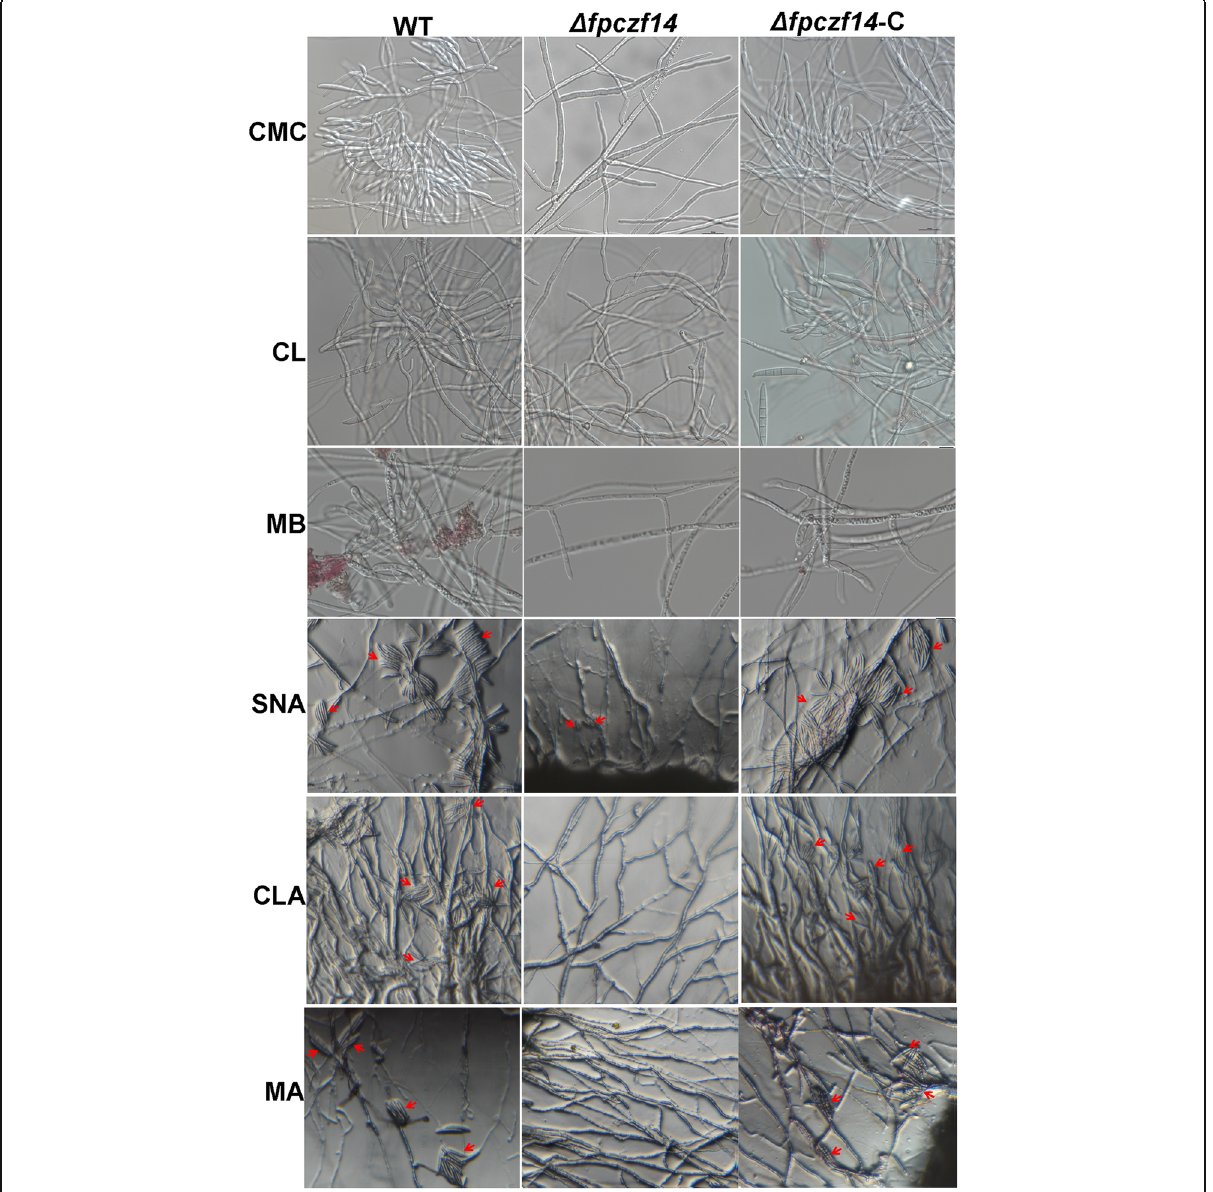
Fig. 4 Microscopic observation of conidia formation by WT, Δ fpczf14 and Δ fpczf14 -C in CMC, CL and MB liquid media (top three rows). Microscopic observation of conidia formation by WT, Δ fpczf14 and Δ fpczf14 -C on SNA, CLA and MA plates (bottom three rows). Red arrows point to